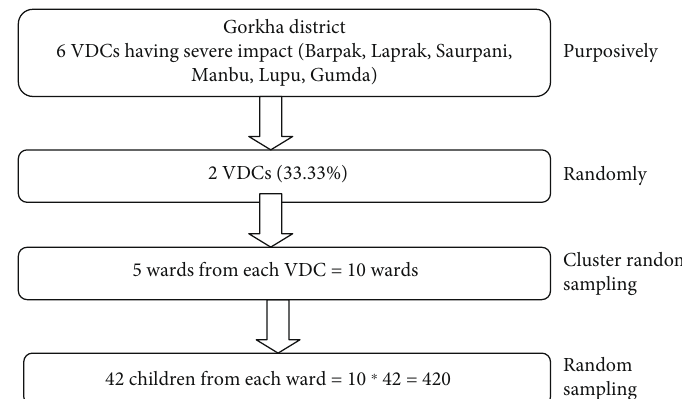
Figure 1: Sampling